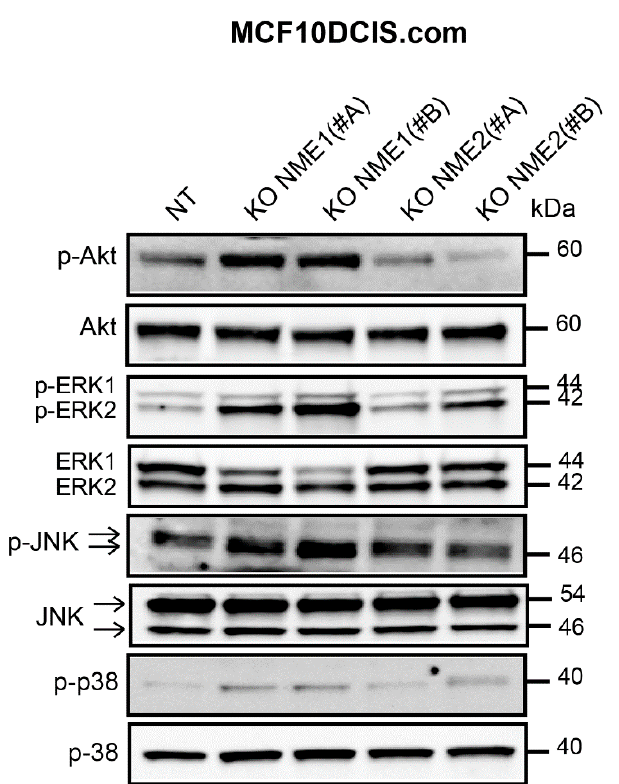
Figure 7. Inactivation of NME1 stimulates the activity of pro-EMT signaling pathways. Lysates of control (NT) and NME1 or NME2 -ablated (KO) MCF10DCIS.com cells were analyzed by Western blotting with antibodies against the phosphorylated forms of Akt (p-Akt), ERK1/ERK2 (p-ERK1/ERK2), JNK (p-JNK) and p38 (p-p38). Molecular weights are indicated in kDa.